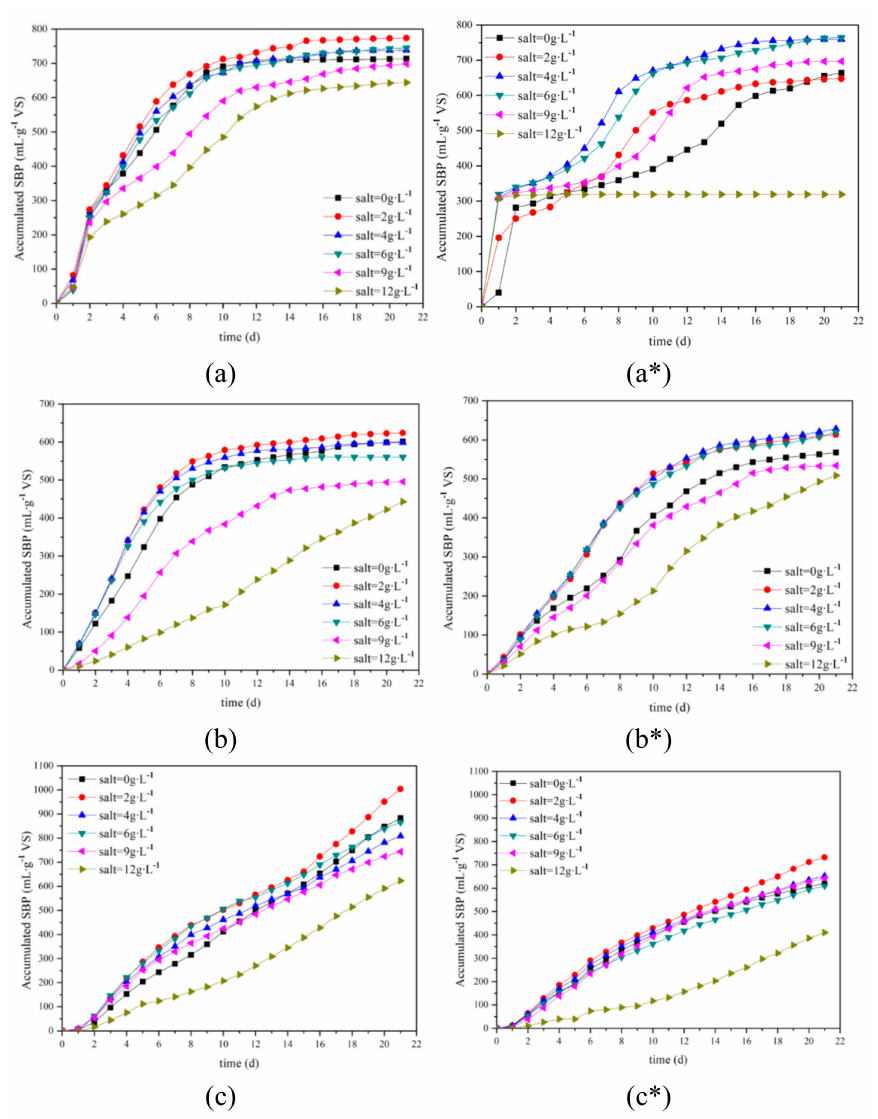
Figure 3. Accumulated specific biogas production of ( a ) HCFW, ( b ) HPFW, ( c ) HFFW with di ff erent salt additions under 5 (without *) and 8 (with *) gVS · L − 1